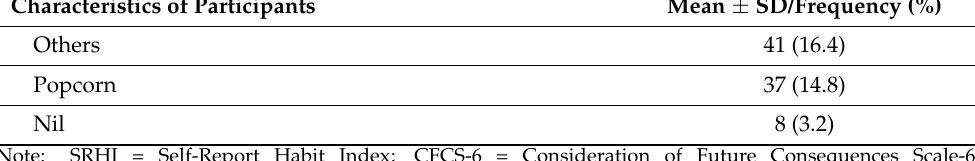
Table 2. Cont . Characteristics of